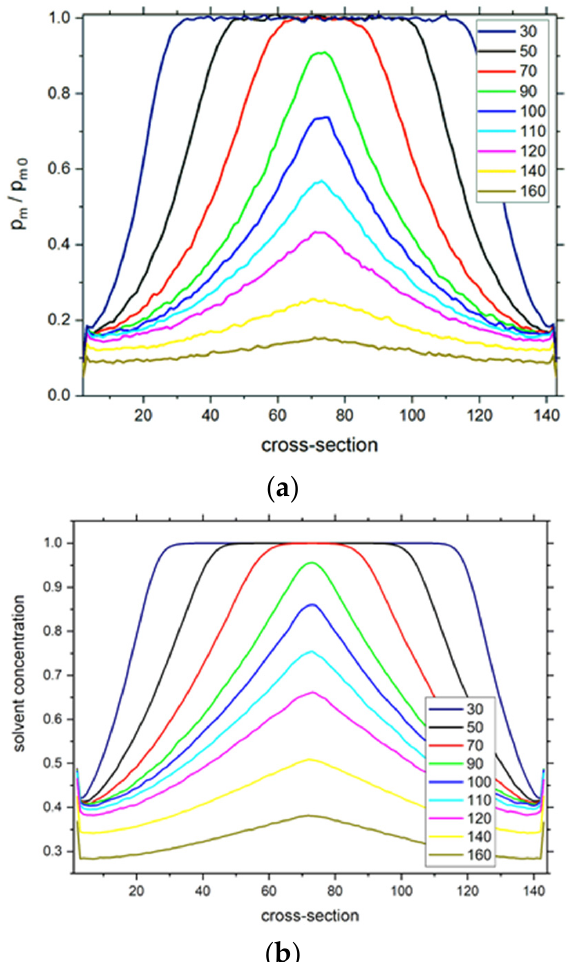
Figure 4. The normalized solvent mobility p m / p m 0 as a function of the position across the slit ( a ). Solvent density profiles ( b ). The degrees of polymerization DP n are given in the insets. The case of σ = 0.3.